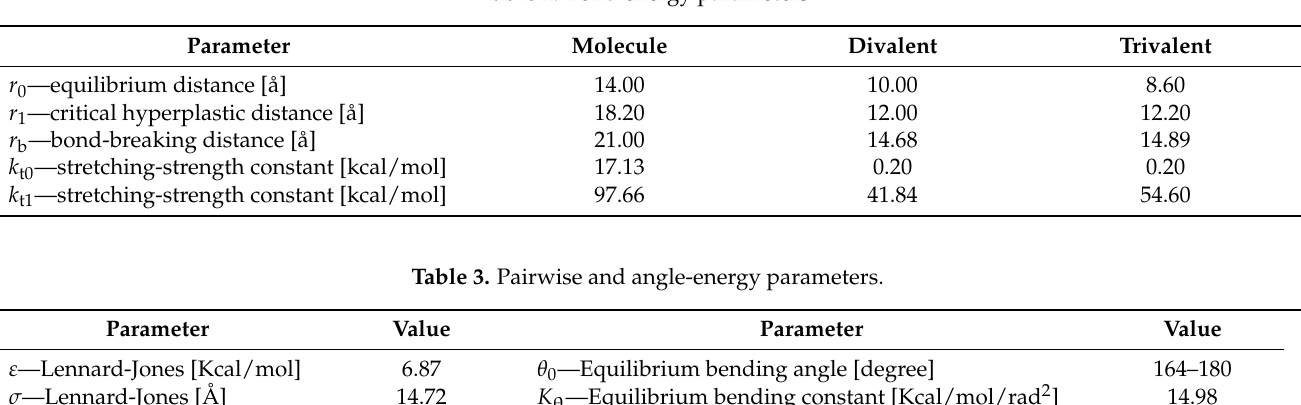
Table 2. Bond energy parameters.